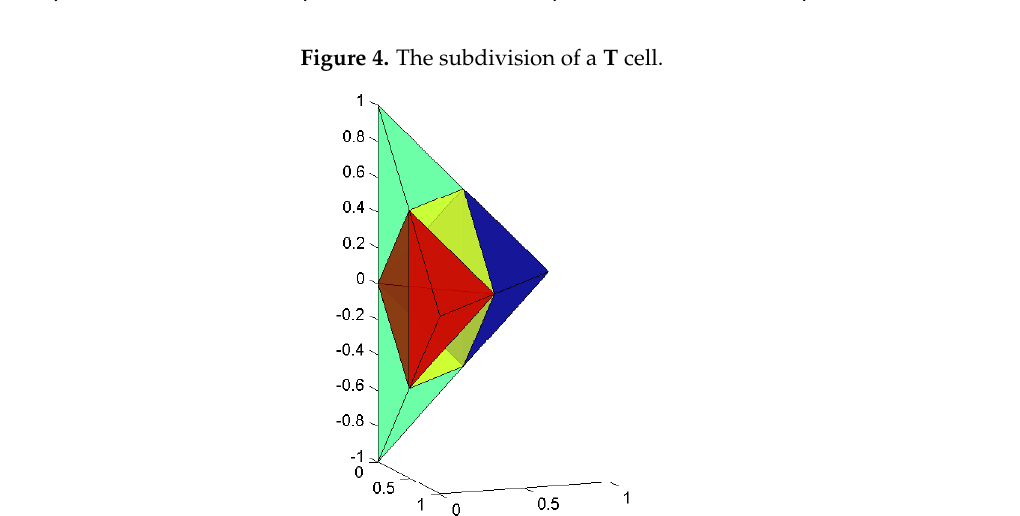
Figure 5. The first step of the refinement: the cell T 0 is divided into two cells of type M 1 (yellow) and six cells of type T 1 : two red, two blue and two